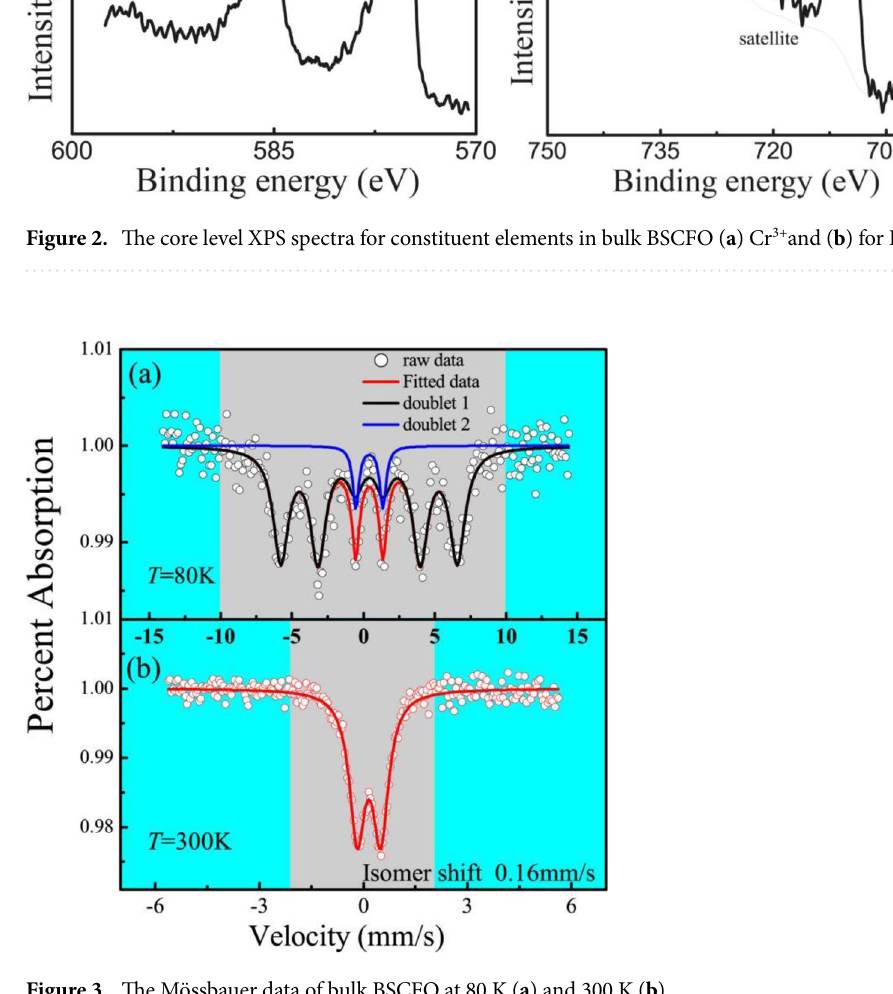
Figure 3. The Mössbauer data of bulk BSCFO at 80 K ( a ) and 300 K ( b